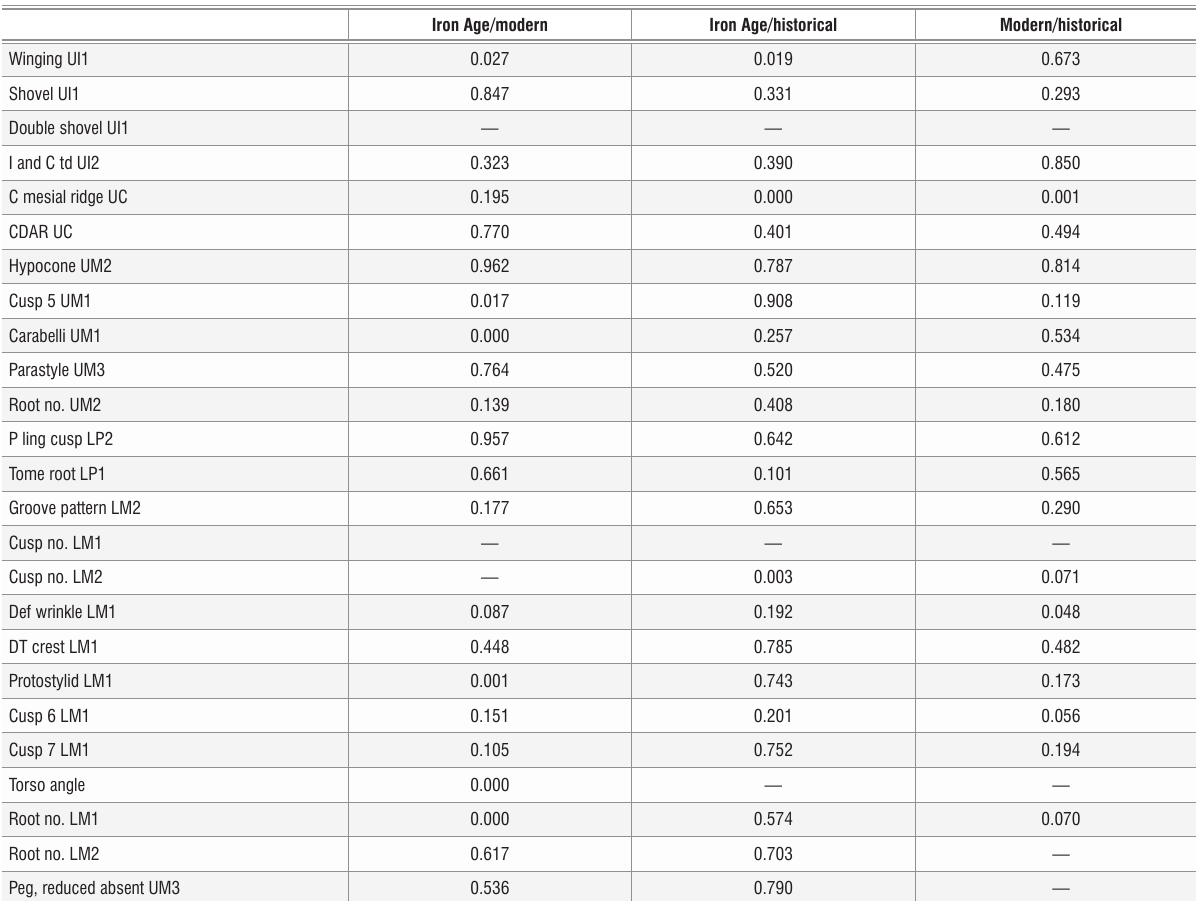
Table 4: Chi-squared p -values for non-metric dental comparisons among the modern, historical and Iron Age samples Iron